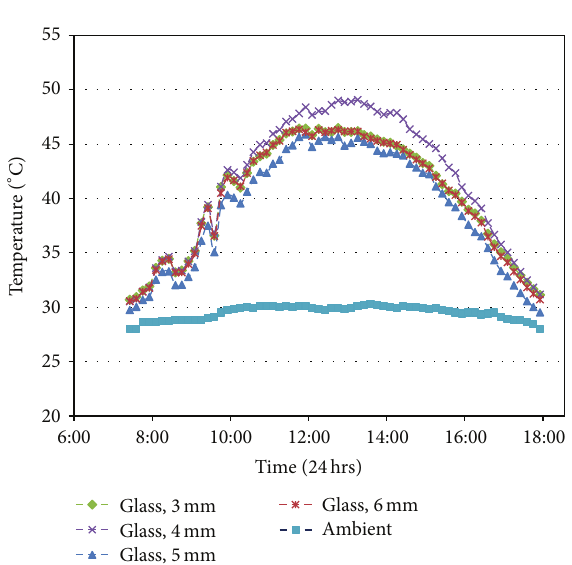
Figure 4: Temperature profiles of collector with different glass thicknesses on